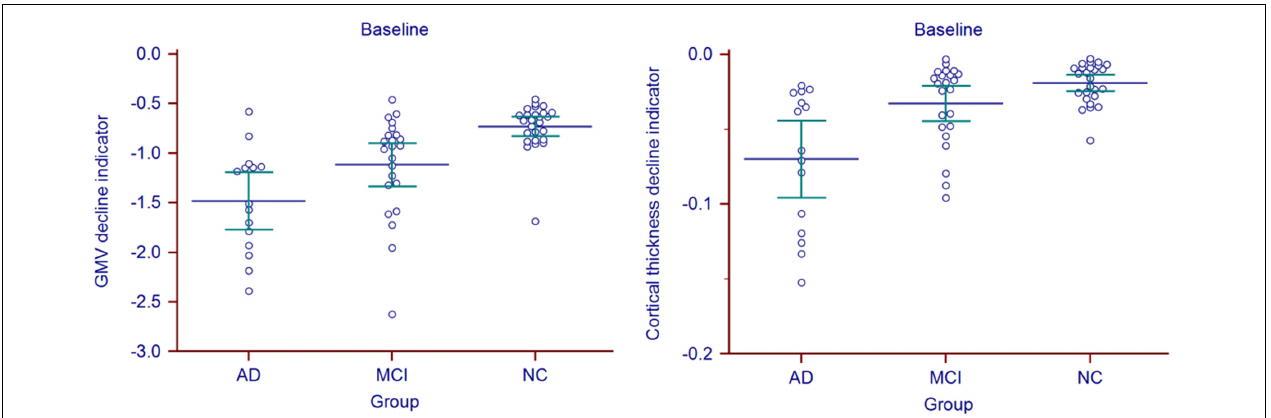
map, while we used modulated, i.e., GMV images followed by global GMV normalization for we wanted to compare the absolute amount of gray matter to quantitatively assess the gray matter loss.